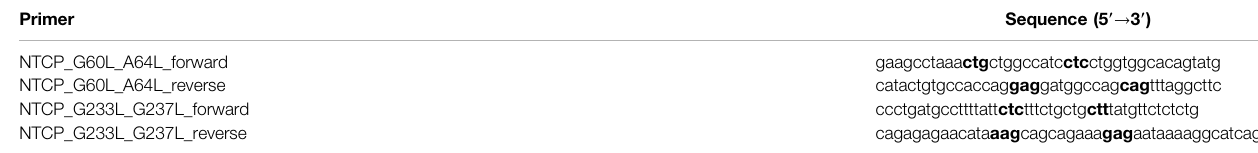
Bold letters in the respective primer sequences indicate the codons changed for